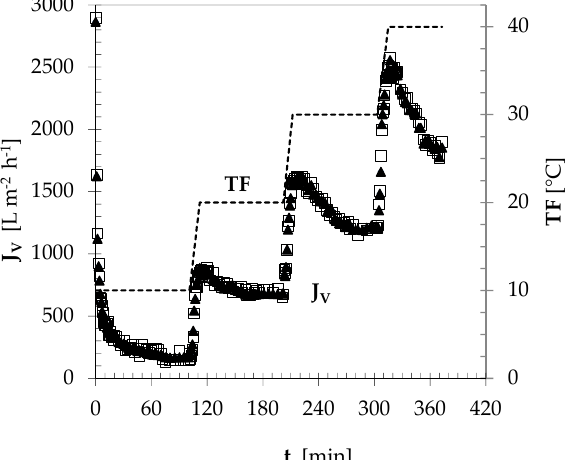
Figure 1. E ff ect of the filtration temperature (TF: - -) on the time course of the permeation flux (J V : (cid:3) , ∆ ) of pre-centrifuged rough beer in two crossflow microfiltration (CFMF) trials performed in the total recycle mode as reported in the text.